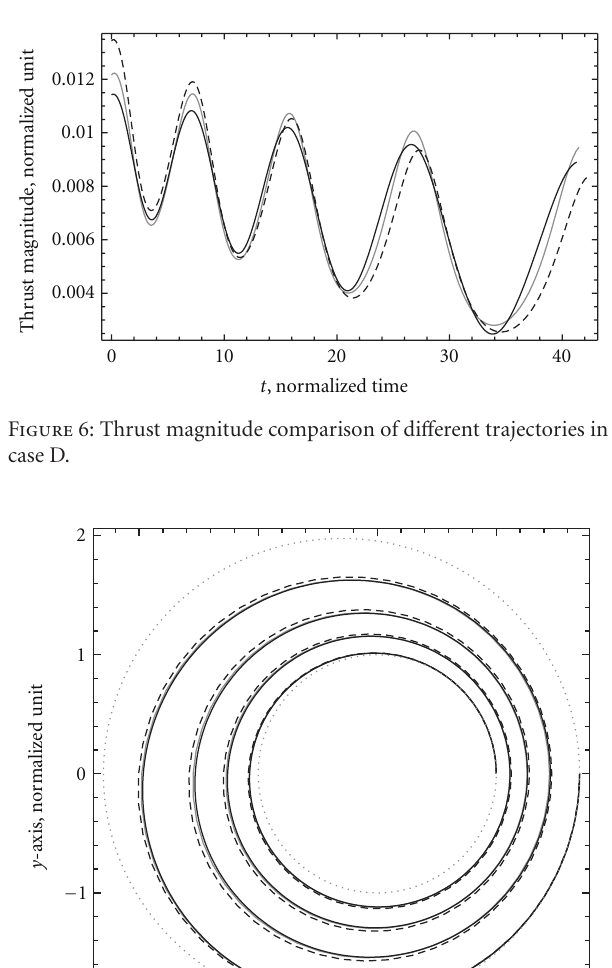
solutions are still feasible. This is a major advantage of using the primer vector approximation